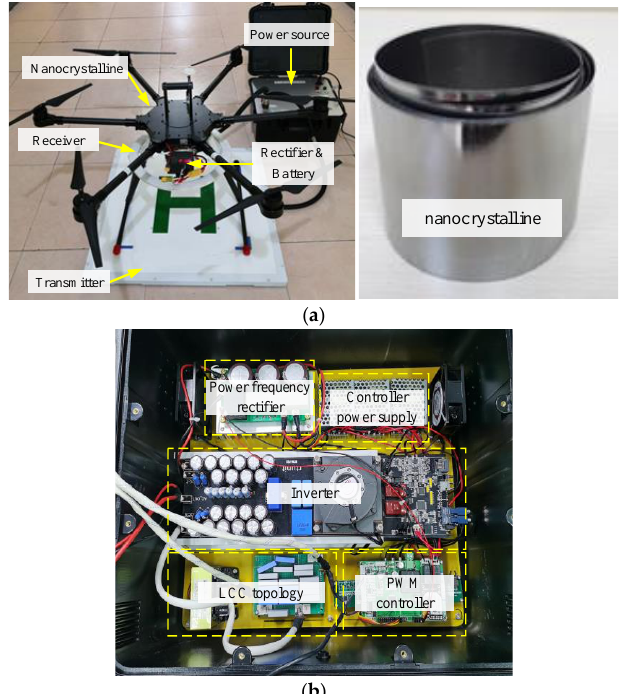
Figure 17. Experimental prototype. ( a ) Experimental system and ( b ) portable transmitter’s power source. Table 3. Detailed coil parameters.